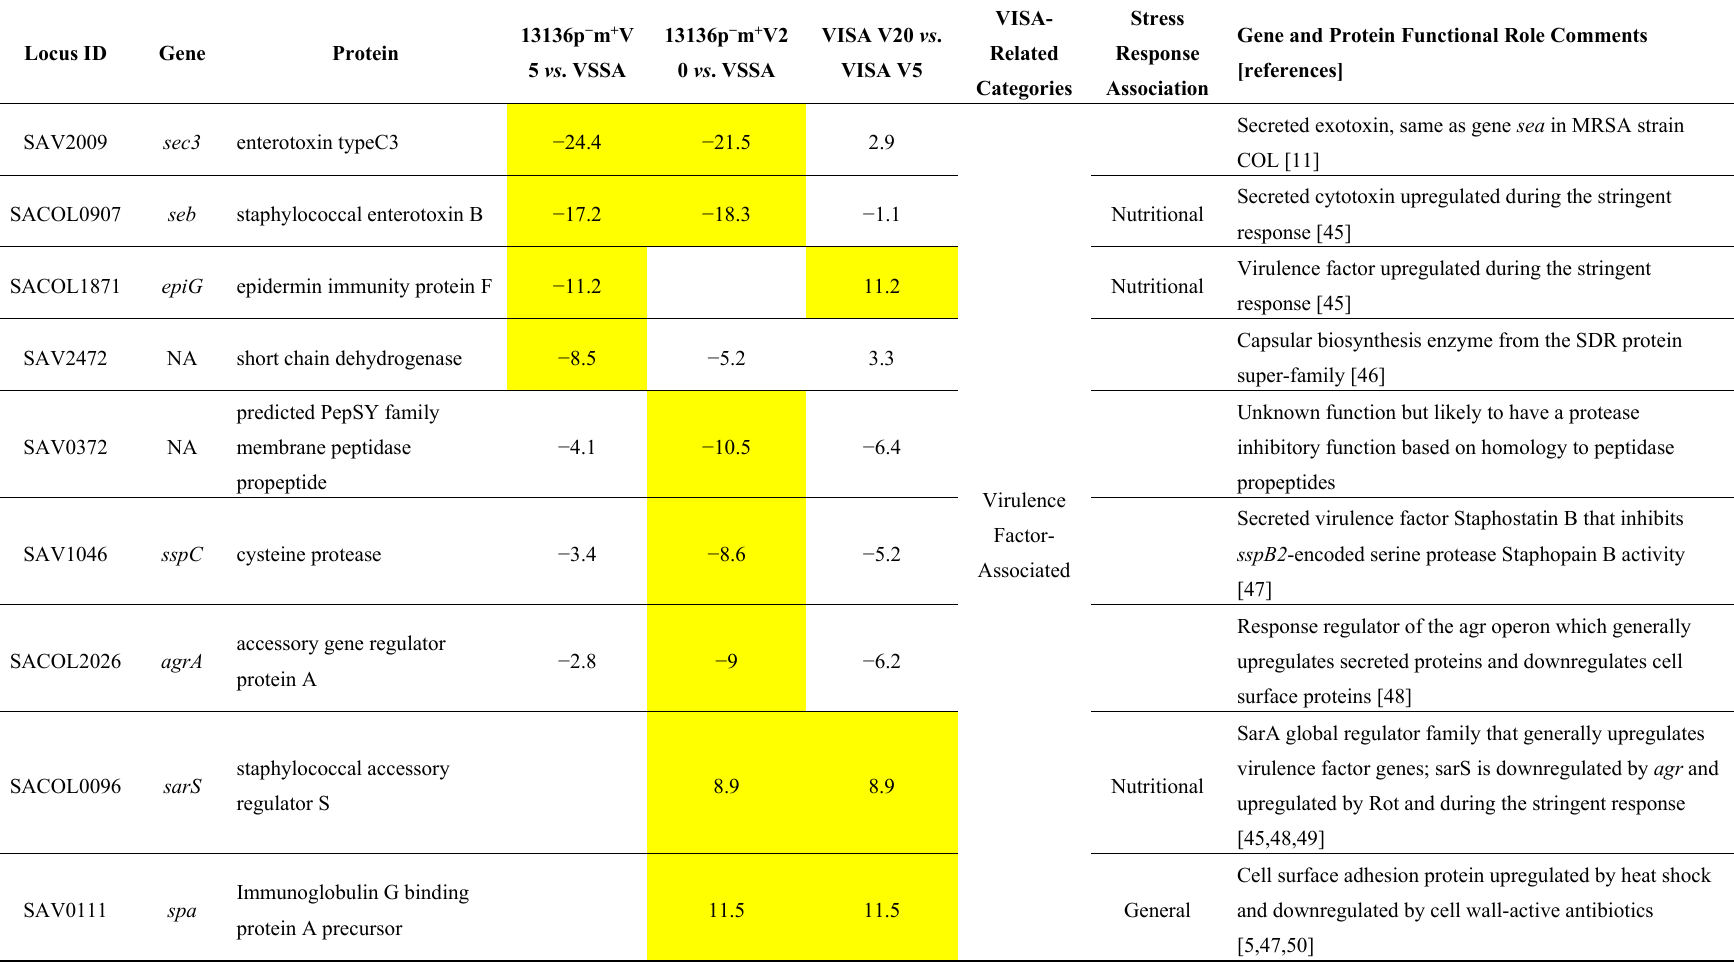
Table 2. Expression patterns and assigned functional roles for genes with at least one > 8-fold expression increase or decrease (yellow cells) between VSSA 13136p - m + and VISA or VISA 13136p − m + V5 and 13136p − m + V20. Locus ID Gene Protein